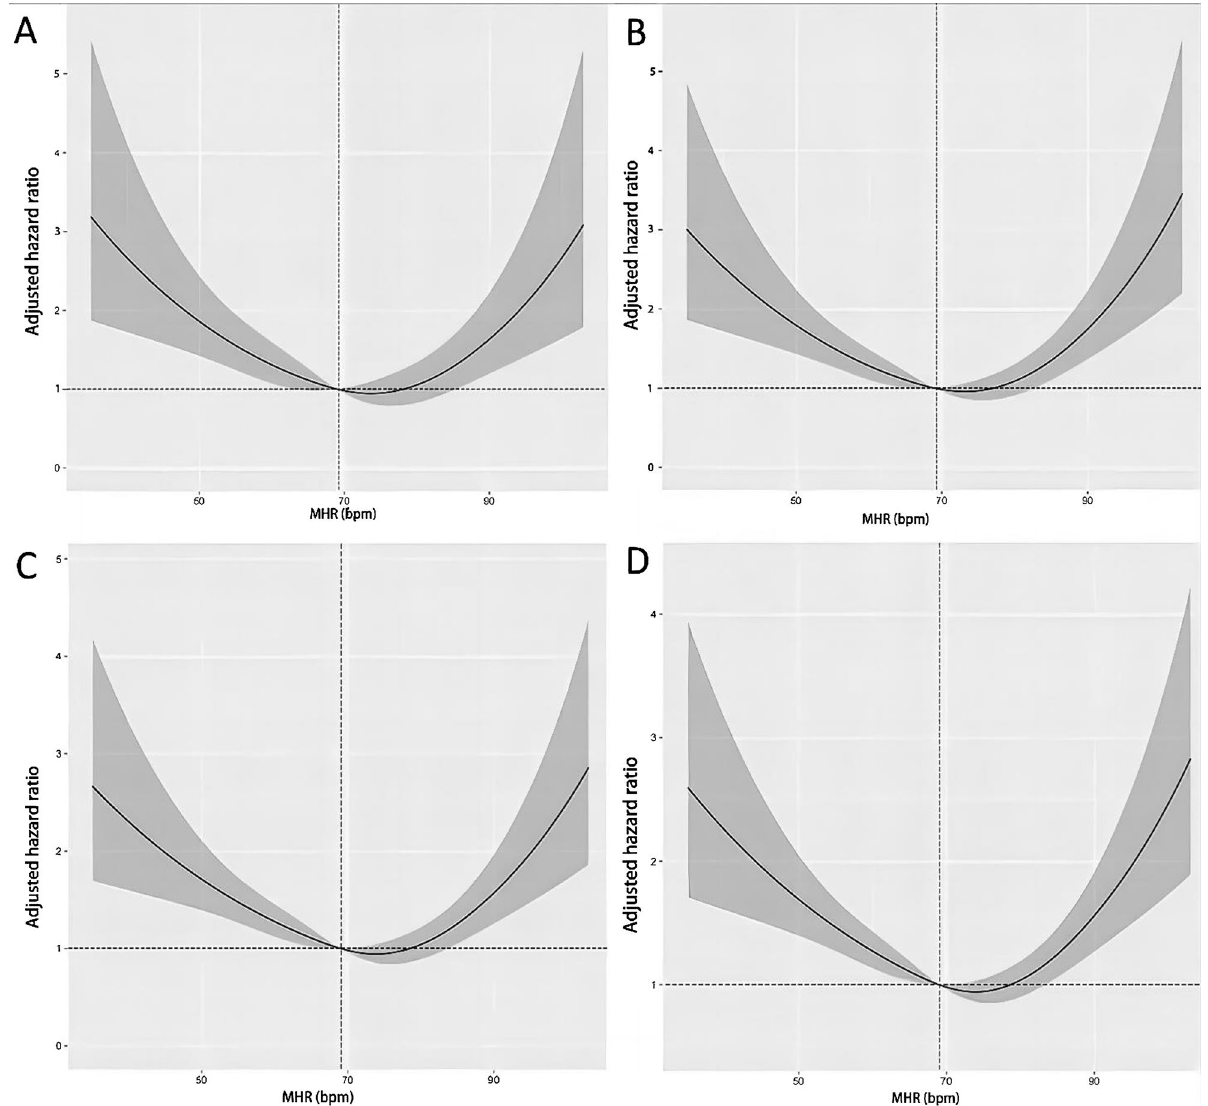
Figure 2. Association between MHR and outcomes of patients undergoing cardiac surgery. Adjusted hazard ratio and 95% CI for MHR in 30-day mortality ( A ), 90-day mortality ( B ), 180-day mortality ( C ), and 1-year mortality ( D ). Analyses were conducted using a model based on RCS. The reference (hazard ratio = 1, horizontal dotted line) was an MHR of 69 bpm (vertical dotted line). Adjusted variables included age, gender, ethnicity, SOFA score, SBP, DBP, hypertension, diabetes, CKD, and COPD. MHR minimum heart rate, SOFA sequential organ failure assessment, SBP systolic blood pressure, DBP diastolic blood pressure, CKD chronic kidney disease, COPD chronic obstructive pulmonary